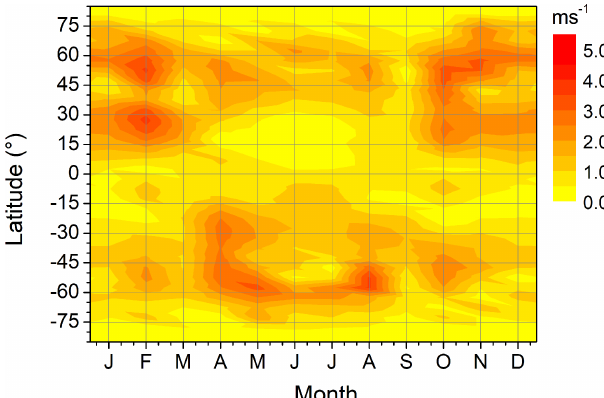
Figure A3. As in Fig. A1, but at 112 . 3km